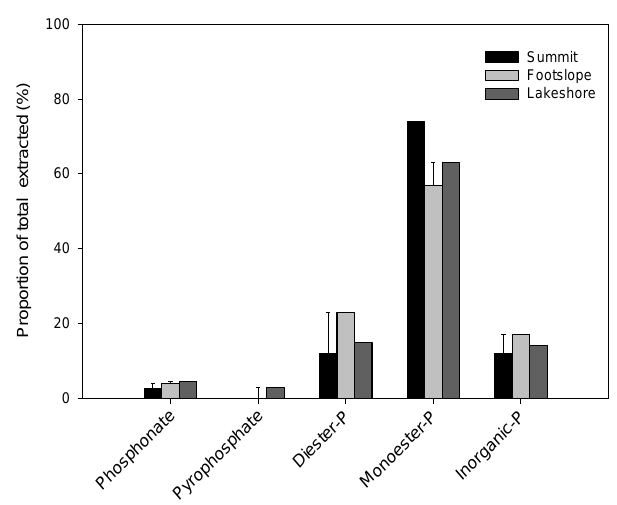
Figure 4. Proportion of extracted P in various classes from humic samples at different sites determined by 31 P-NMR spectroscopy. Error bars indicate standard deviation.